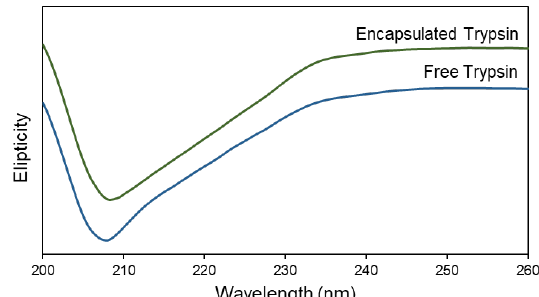
Figure 7. Circular dichroism spectrums of free trypsin and processed and formulated trypsin by